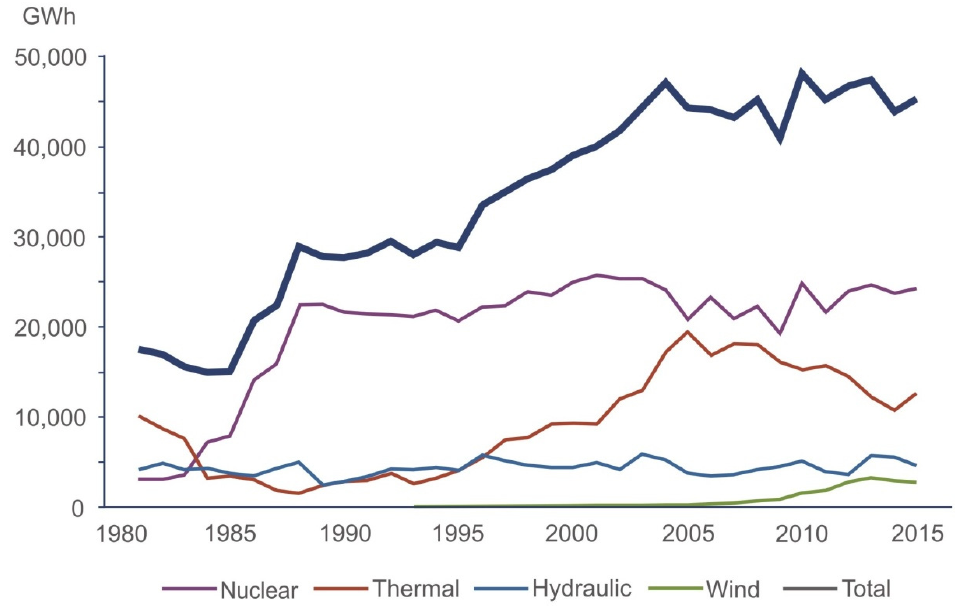
Figure 4. Electricity consumption in Catalonia. Source: Neila, 2003; ICAEN; prepared by the authors.